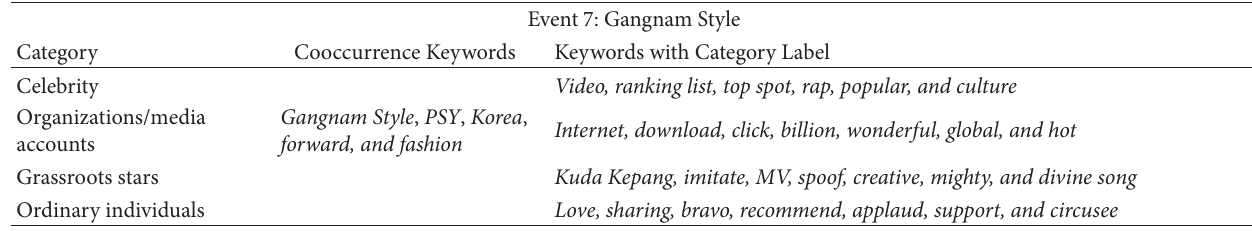
Table 11: Keywords distribution on the event of “Gangnam Style.”